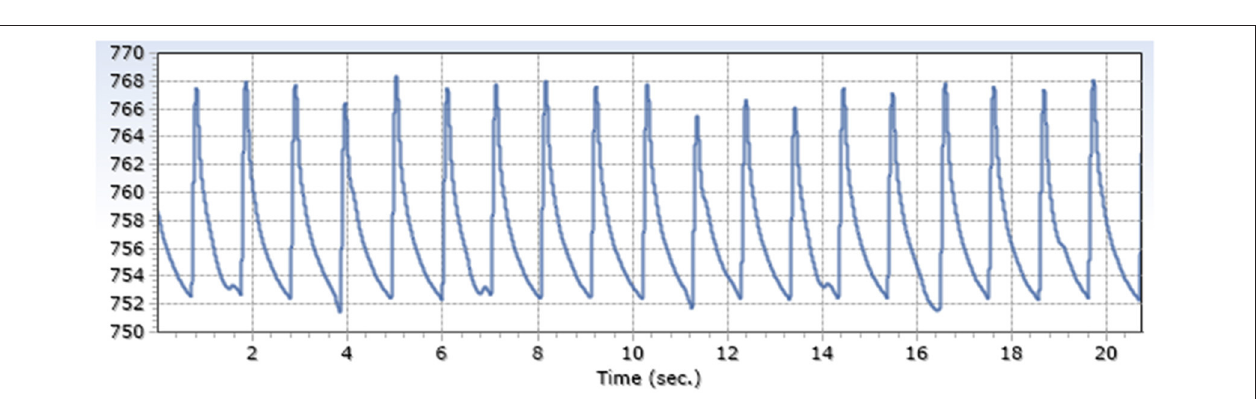
FIGURE 7 | Intraoperative situs. Arrow indicates entrance of the sensor into the vessel, Ring indicates vessel. Sutured vessel with inserted sensor.